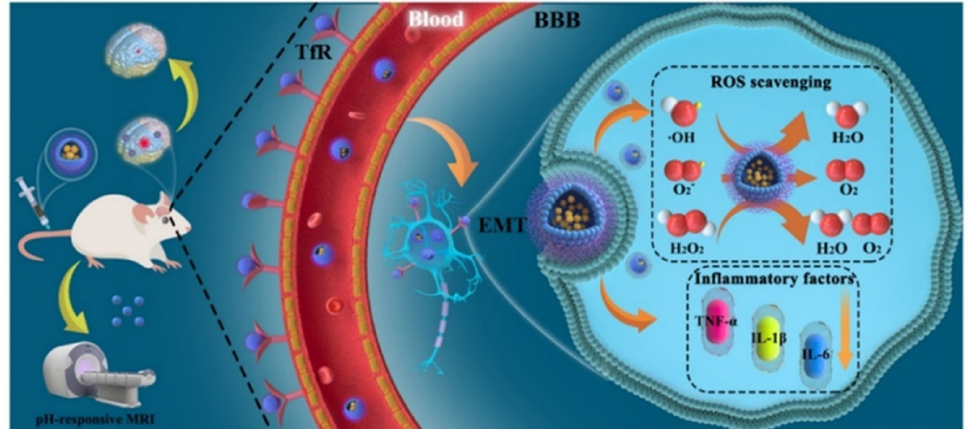
Scheme 1. Schematic illustration showing the targeted process of the EMT nanozyme, the function of MRI, and the therapeutic mechanism of ROS scavenging and inflammatory factor suppression in